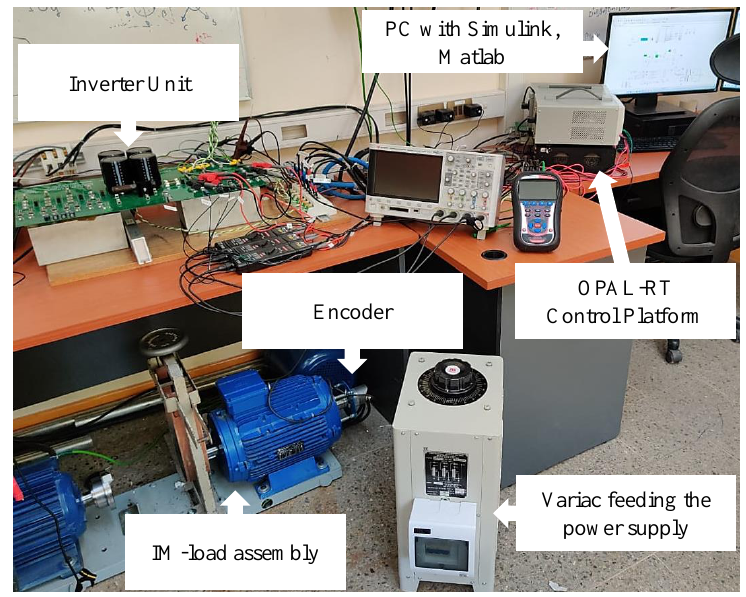
Figure 4. Picture of the testing bench.